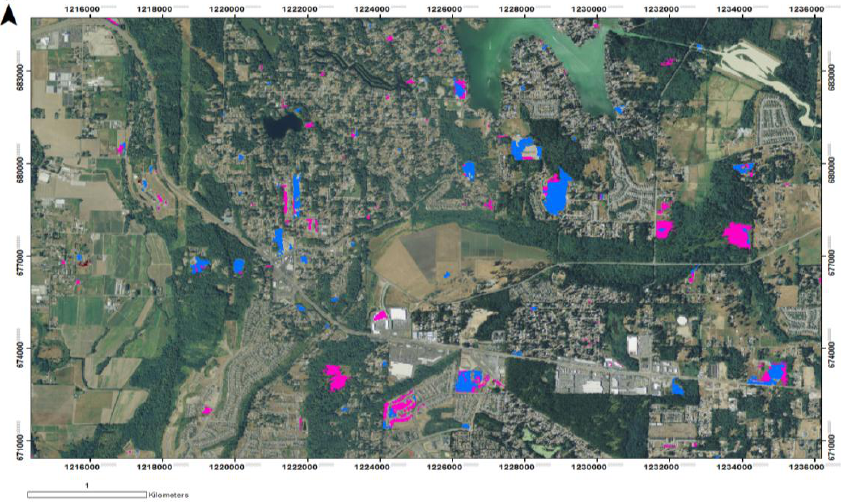
Figure 6. Sample area showing the distribution of AO50 ( blue ) and AO25 ( purple ) change locations. AO50 locations were part of the base map. AO25 locations were mapped during the application of accuracy optimization technique 2. The area shown represents about 1% of the mapped watershed. With a scale of 1:20,000 the smallest mapped change locations (about 200 m 2 ) represent about 8 pixels in the original